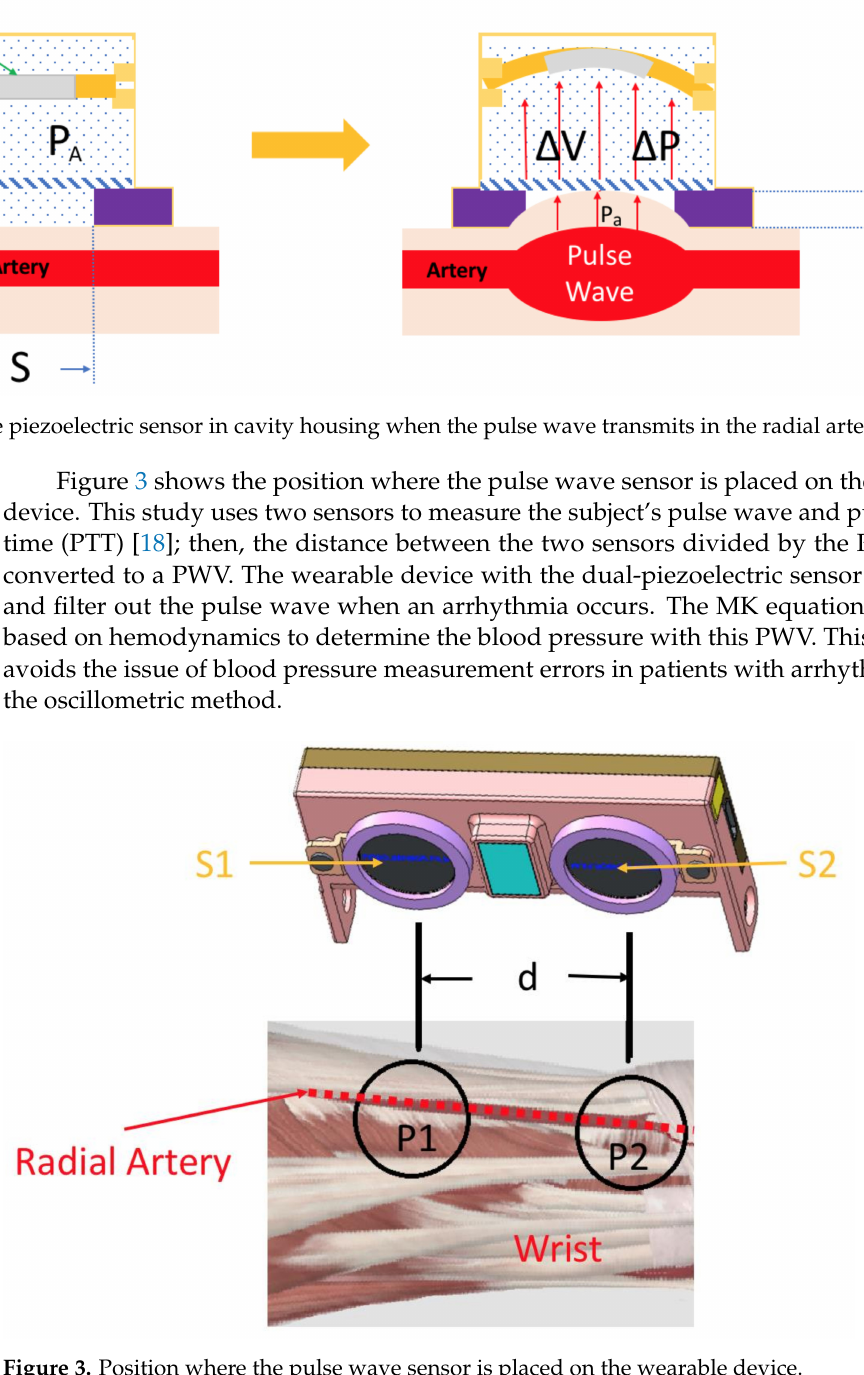
Figure 3. Position where the pulse wave sensor is placed on the wearable